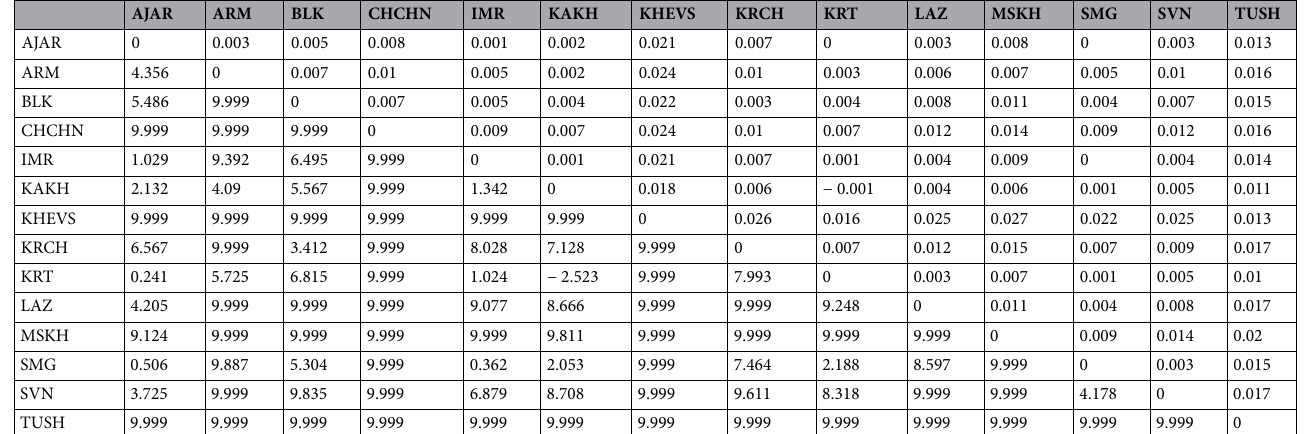
Table 5. Matrix of Fst (upper triangular) and Z-values (lower triangular). Number of samples used: 73; number of SNPs used: 138,782; number of blocks for moving block jackknife: 692.